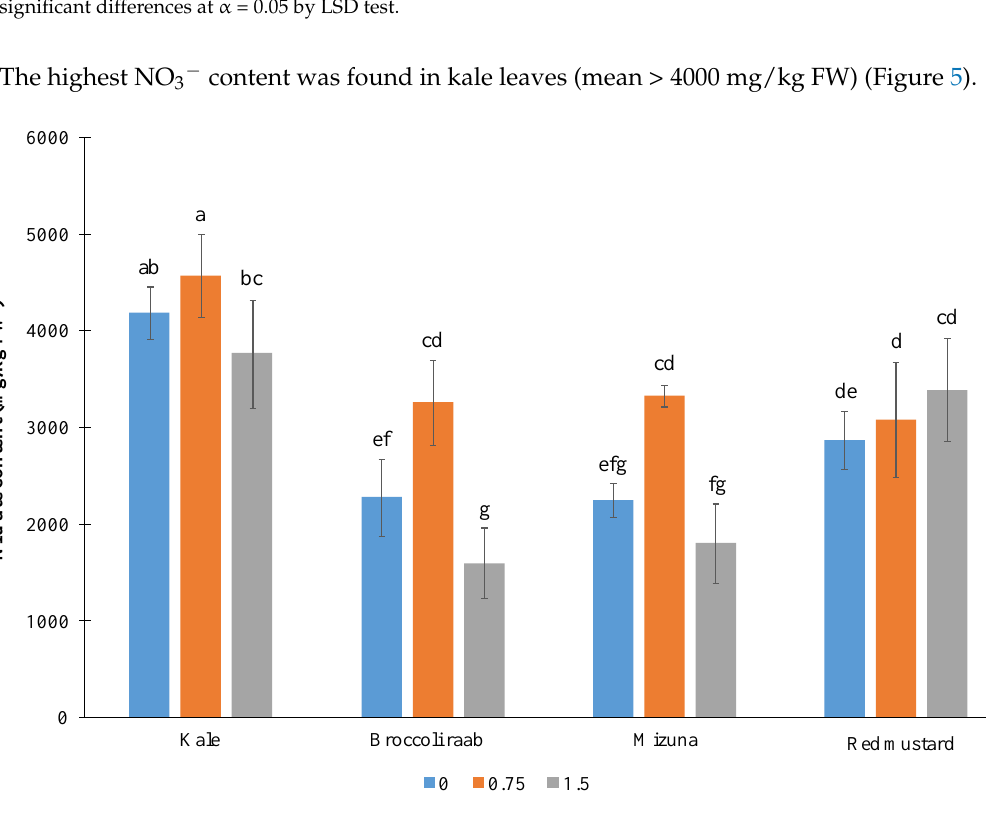
Figure 5. Nitrate content in samples of four Brassica genotypes grown with three I levels (mg/L) in the NS. Interaction significance: p ≤ 0.01. Different letters indicate significant differences at α = 0.05 by LSD test.